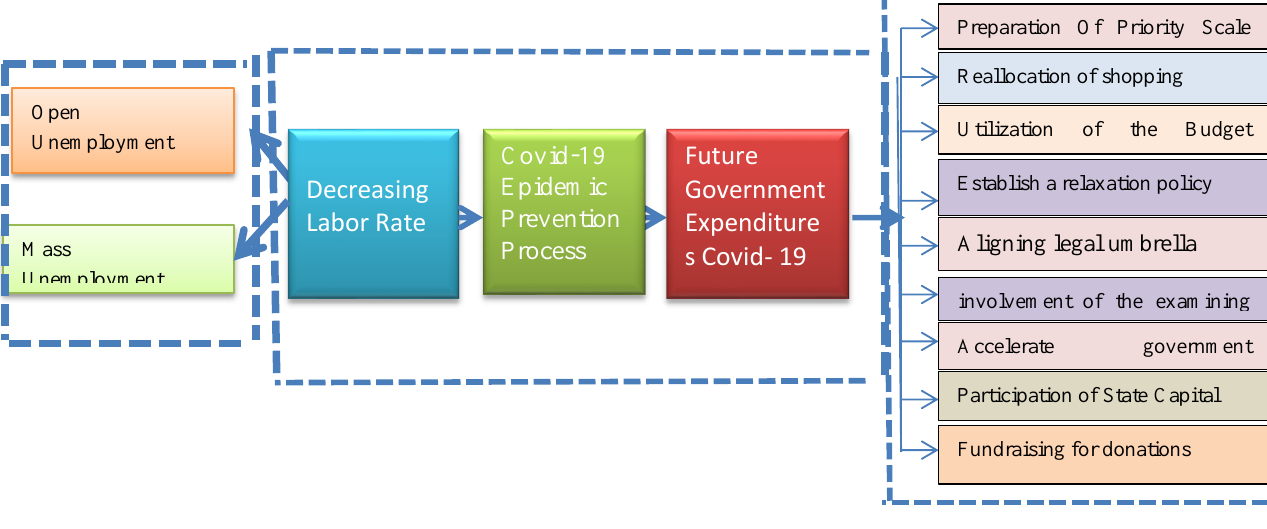
Figure 1: Research conceptual framework